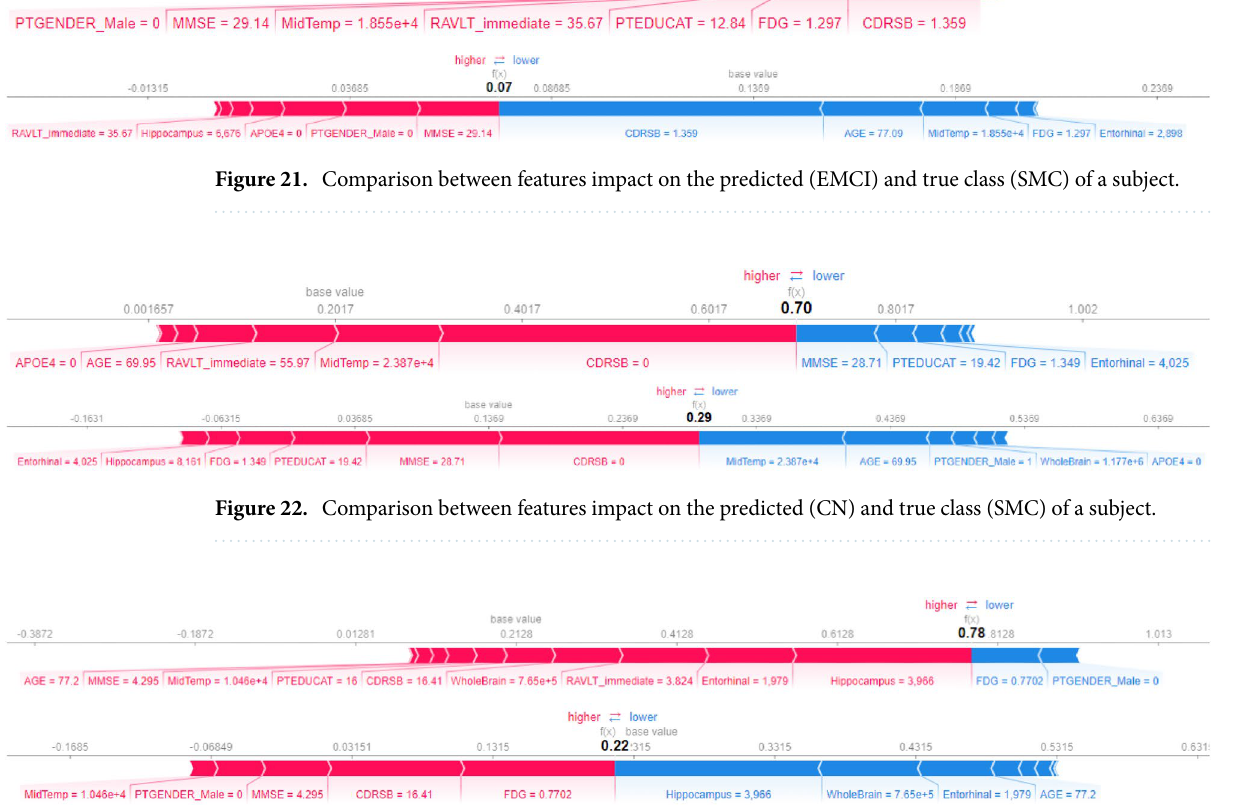
Figure 23. Comparison between features impact on the predicted (LMCI) and true class (AD) of a